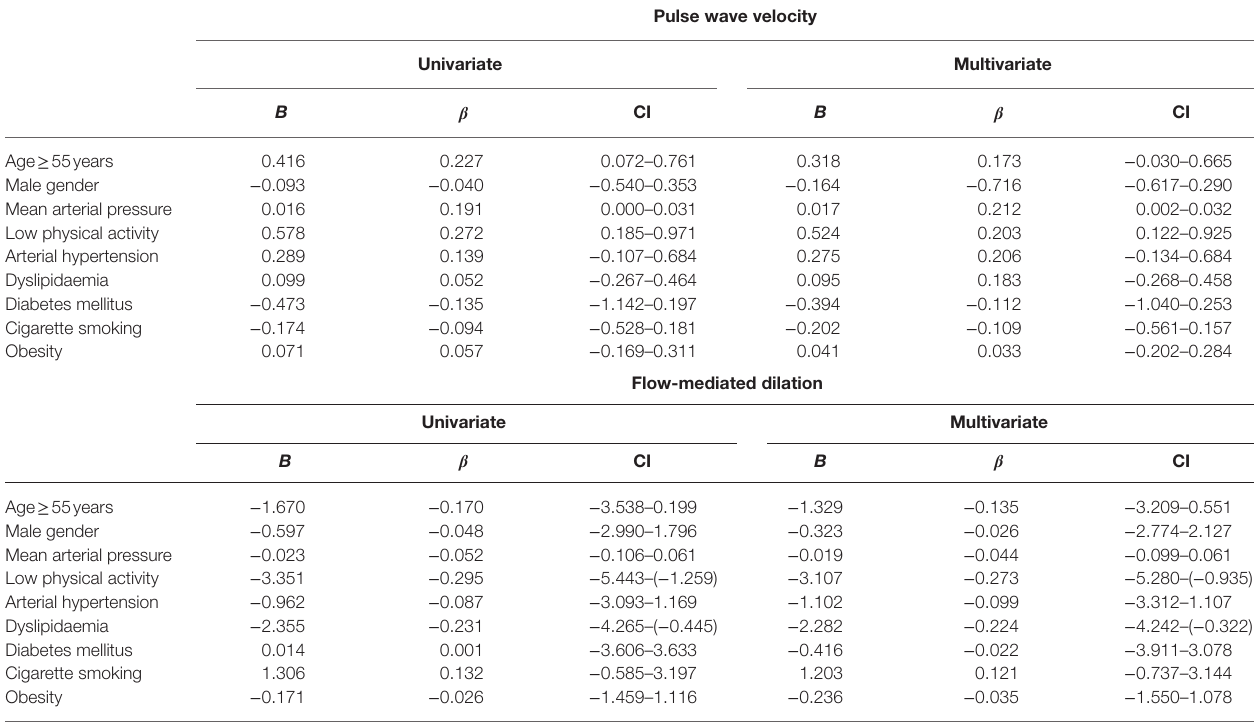
TABLE 3 | Linear regression models with PWV and FMD as dependent